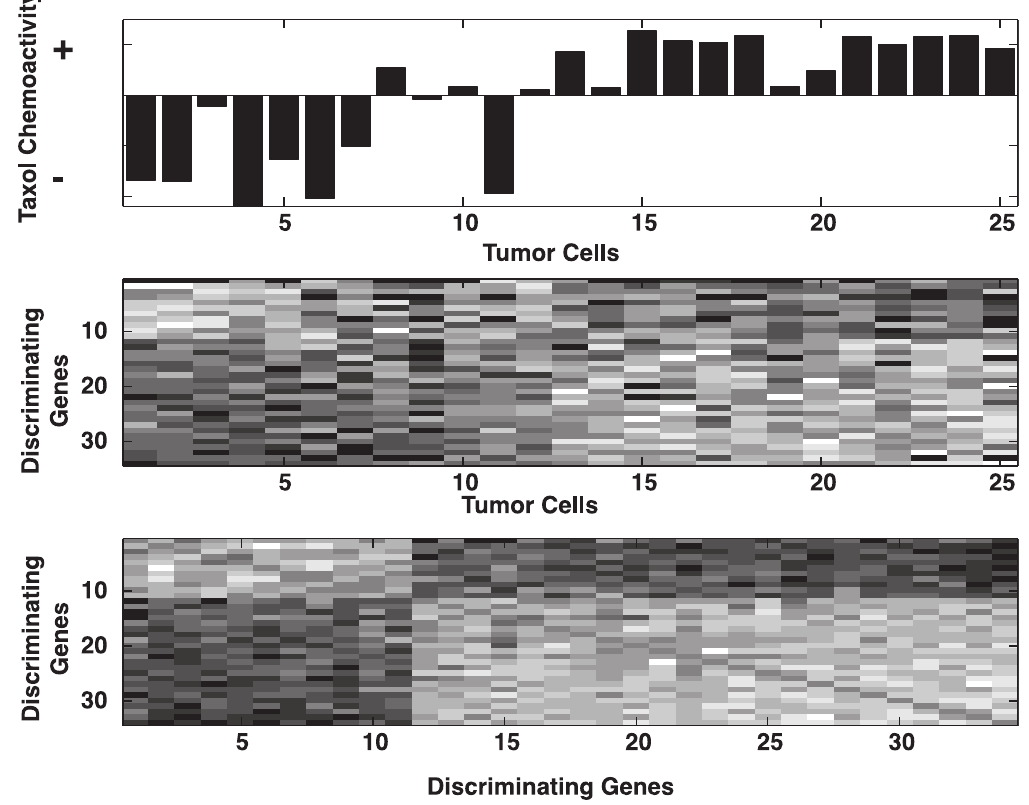
Figure 4. Illustrations of Taxol’s discriminating genes. Top panel displays Taxol’s chemoactivity profile ( + :sensitive 2 ::insensitive) for its 25 discriminating genes, derived from the U133A dataset. The middle panel displays the relative gene expressions (light:over dark:under) for these same tumor cells. The lower panel displays the Pearson correlation scores (positive:light negative:dark) for taxol’s discriminating genes.